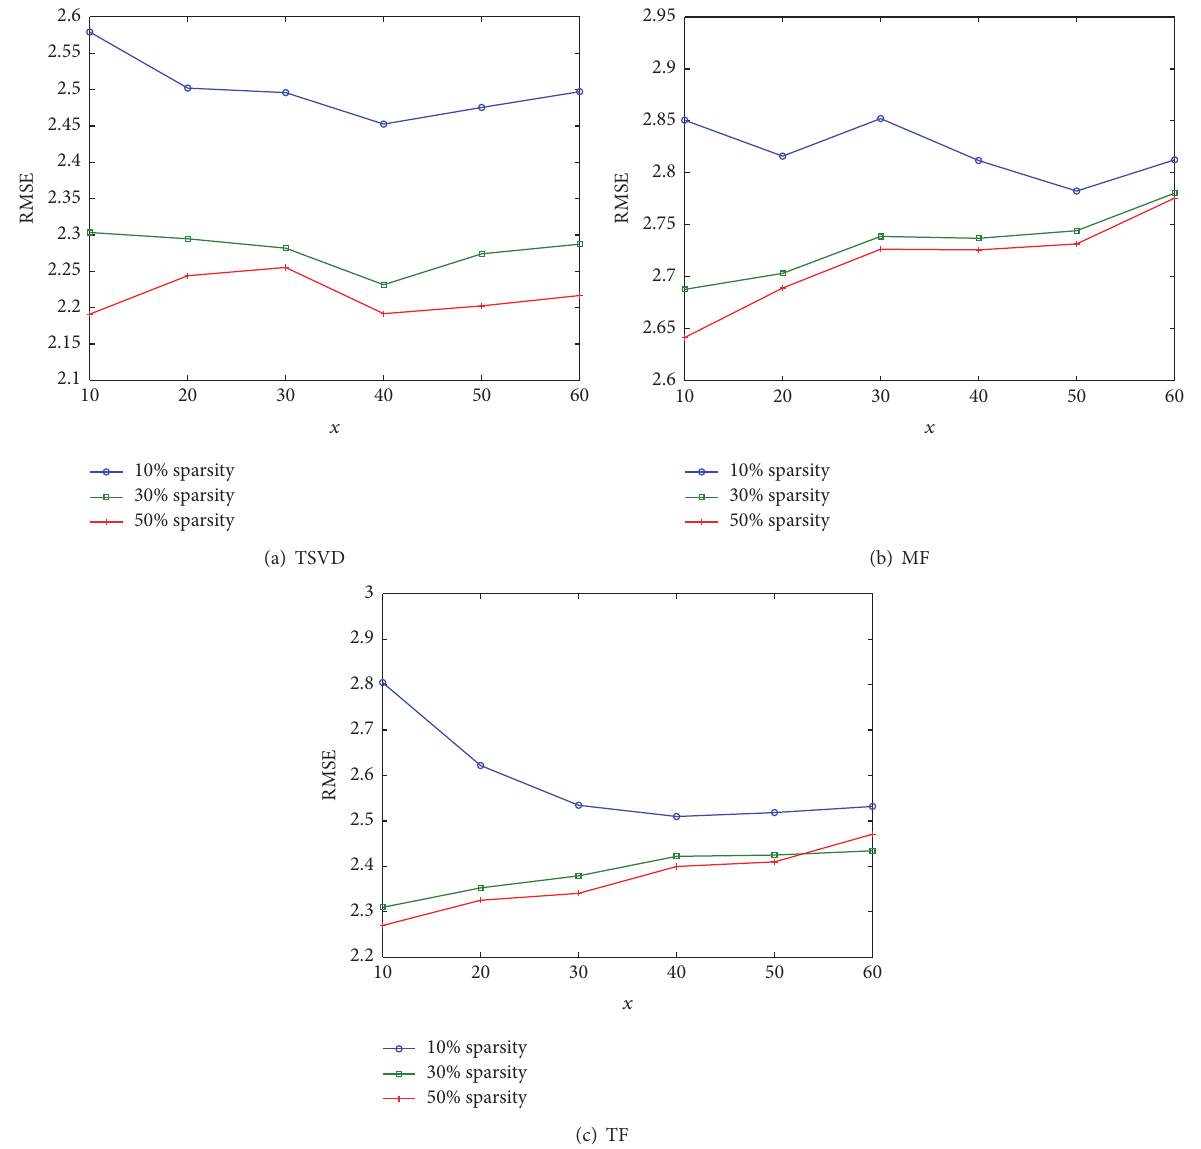
Figure 3: Performance comparison of the offline TSVD, MF, and